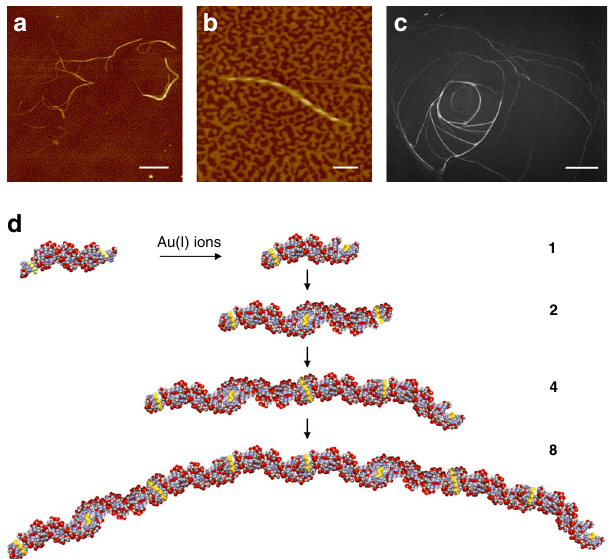
Fig. 4 Au-thiolate-DNA concatemers. AFM height image of Au- [ OligoS 4 ] revealing the extended, micron, lengths of strands formed ( a ) and the helical nature of an individual structure ( b ). c Fluorescence image of Au- [ OligoS 4 ] revealing the macroscopic fi bers. d Schematic illustration of the formation of DNA-semiconductor concatemer sequence strands by metal-ion-driven self-assembly. Yellow indicates the semiconducting Au-thiolate region, red = Oxygen, purple = Nitrogen, gray = Carbon. Scale bar is 500 nm in image a , 100 nm in image b , and 1 mm in image